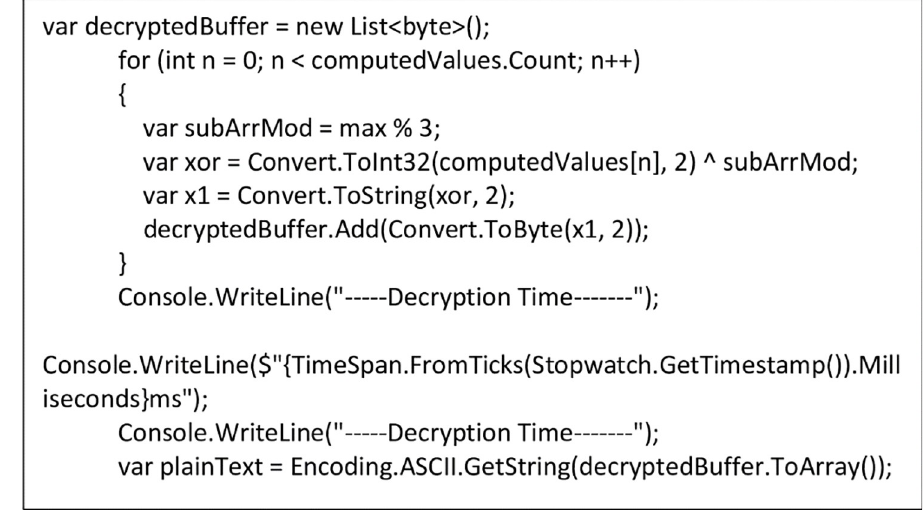
Fig 10. Decryption of encoded data into plaintext using NCS algorithm.